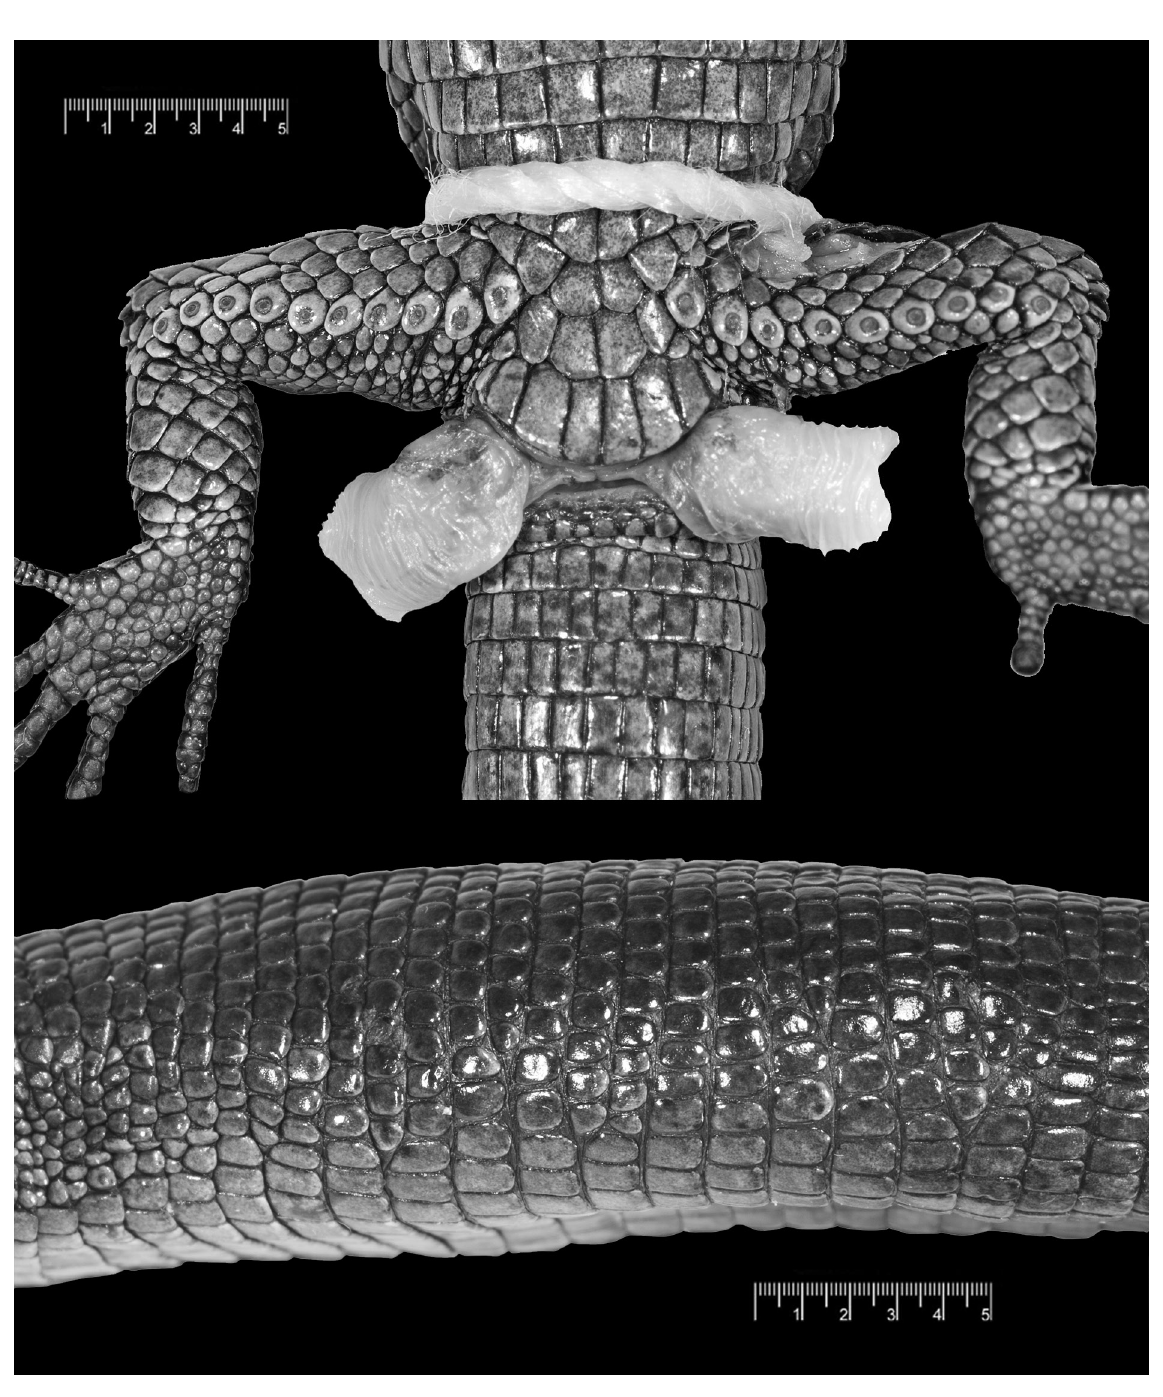
Fig. 3. Anadia mcdiarmidi sp. nov. Subpelvic region of the preserved ♂ holotype (IRSNB 2677), showing preanal scales and femoral pores, and trunk of the preserved holotype in lateral view (head to left), showing scalation at midbody. Scale lines = 5 mm. Photographs by Philippe J.R.